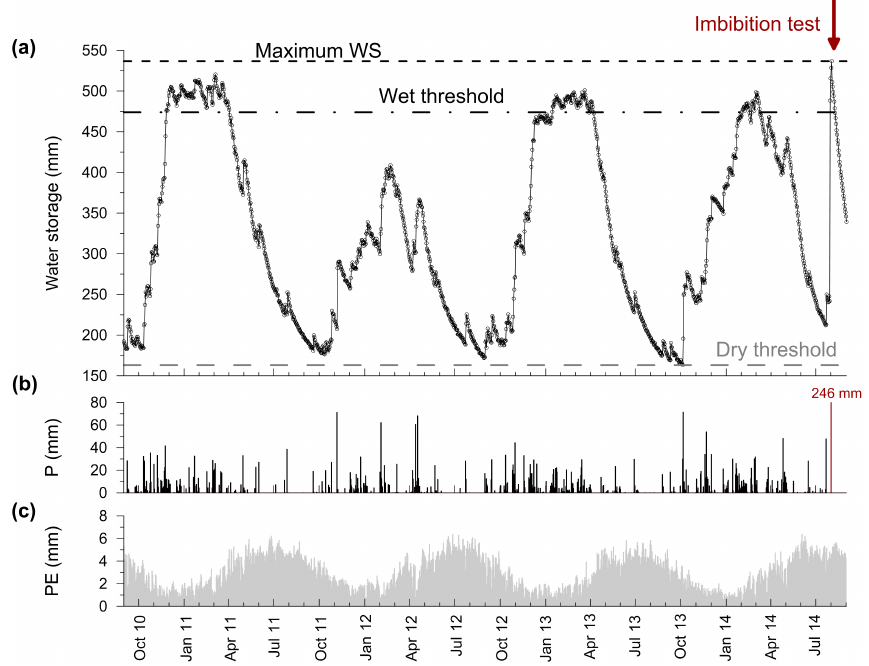
Figure 5. Evolution of variables recorded by the physical model of lysimeter: (a) layer water storage (WS); (b) daily precipitations ( P );